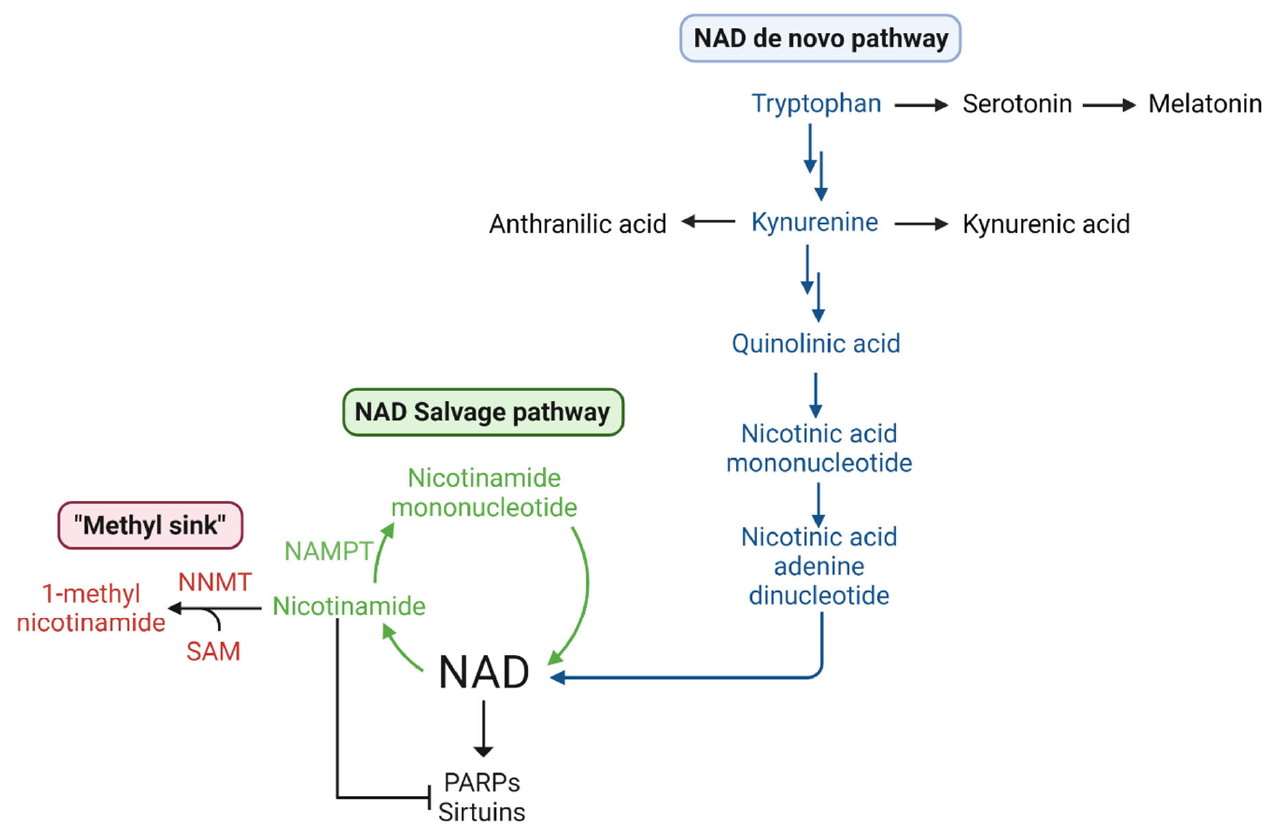
Figure 3. NAD Synthesis by de novo and salvage